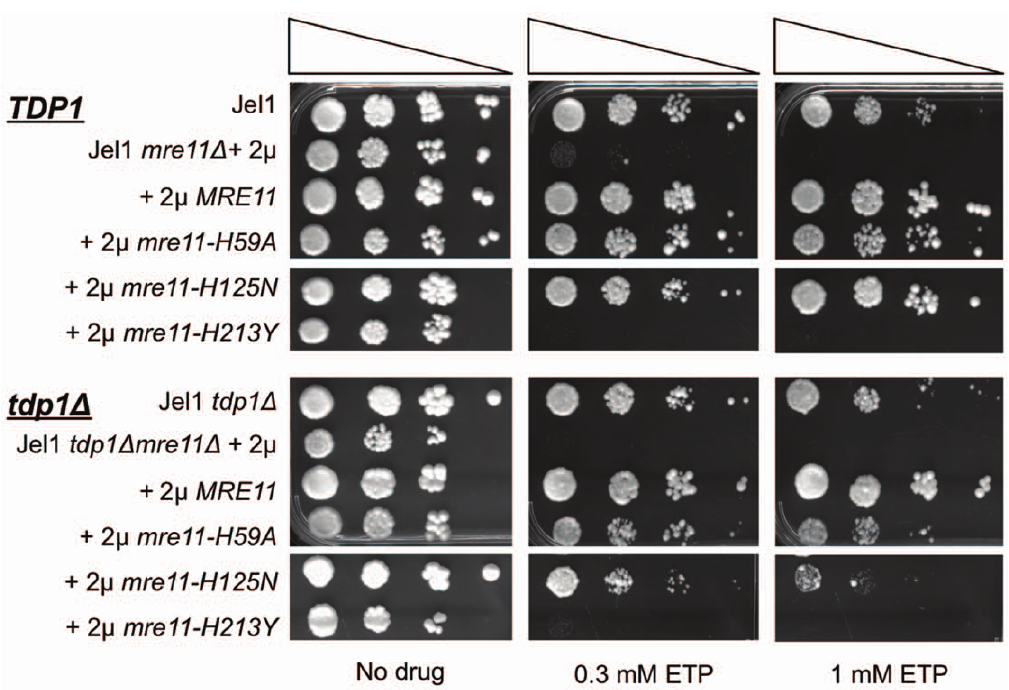
Figure 4. TDP1 contributes to ETP-resistance of mre11-H59A and mre11-H125N strains. Serial spot dilution assays of sensitivity to ETP of indicated S. cerevisiae derivatives of parental line Jel1; notations as in Fig. 3. Cells were spotted at 10-fold serial dilutions on rich plates containing no drug (left) or indicated concentrations of ETP.